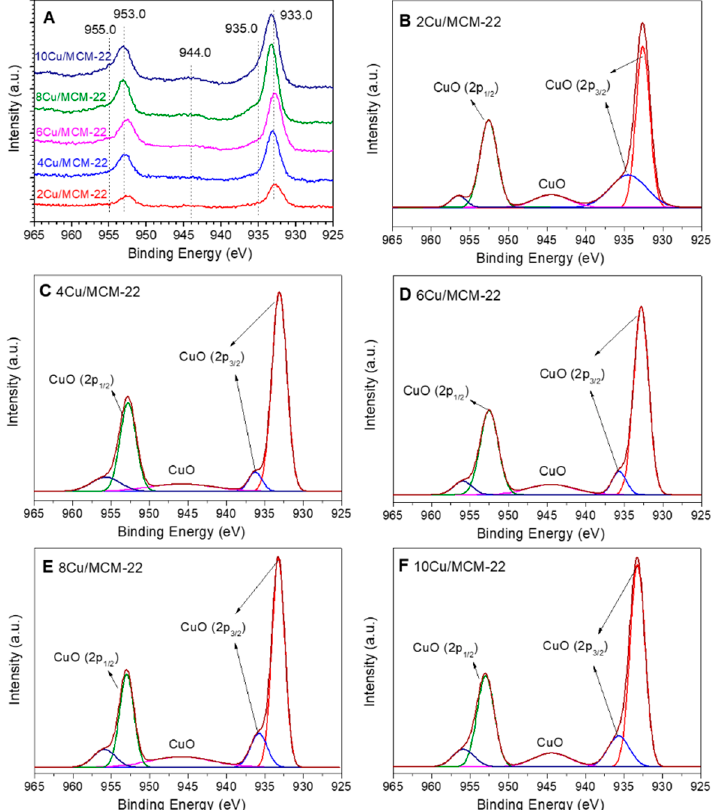
Figure 6. Cu 2p XPS spectra of x Cu/MCM-22 with different Cu contents: ( A ) original spectra and deconvolution spectra of ( B ) 2Cu/MCM-22, ( C ) 4Cu/MCM-22, ( D ) 6Cu/MCM-22, ( E ) 8Cu/MCM-22 and ( F ) 10Cu/MCM-22.